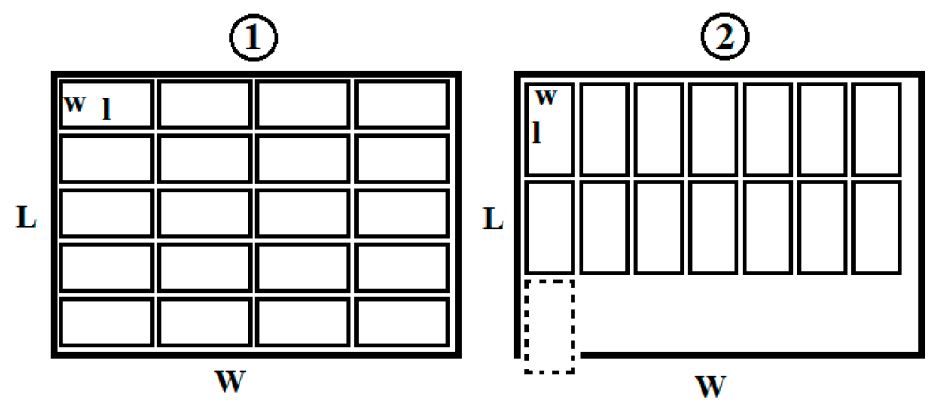
Figure 3. PV system layout options based on roof space constraint in system sizing [2].